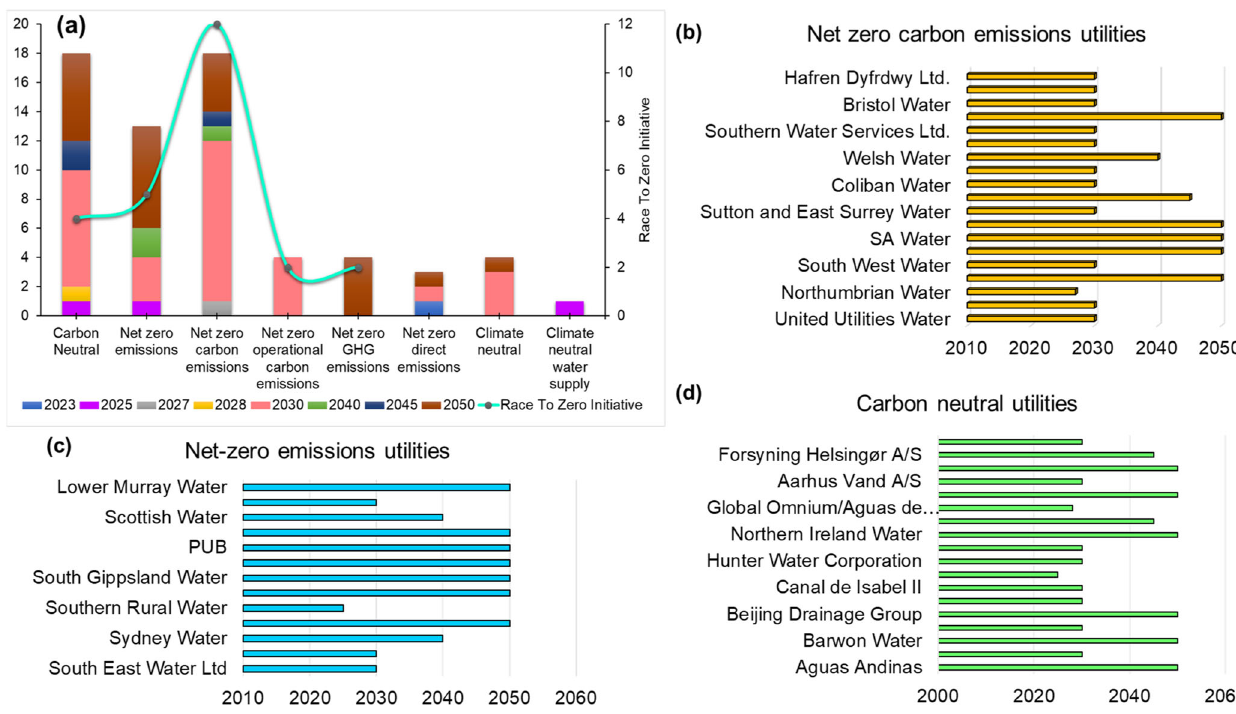
Fig. 6 Water utilities ’ and WWTPs ’ commitments toward the net-zero or climate neutrality targets. a Summary of year-based commitments. b Net-zero carbon emission utilities, c Carbon-neutral utilities, and d Net-zero emission utilities [Adapted from ref. 168